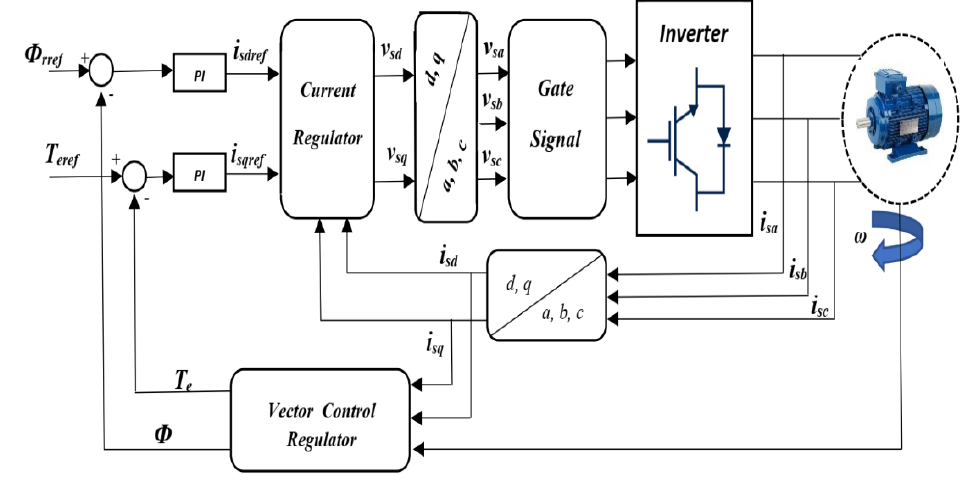
Figure 3. Vector control scheme.